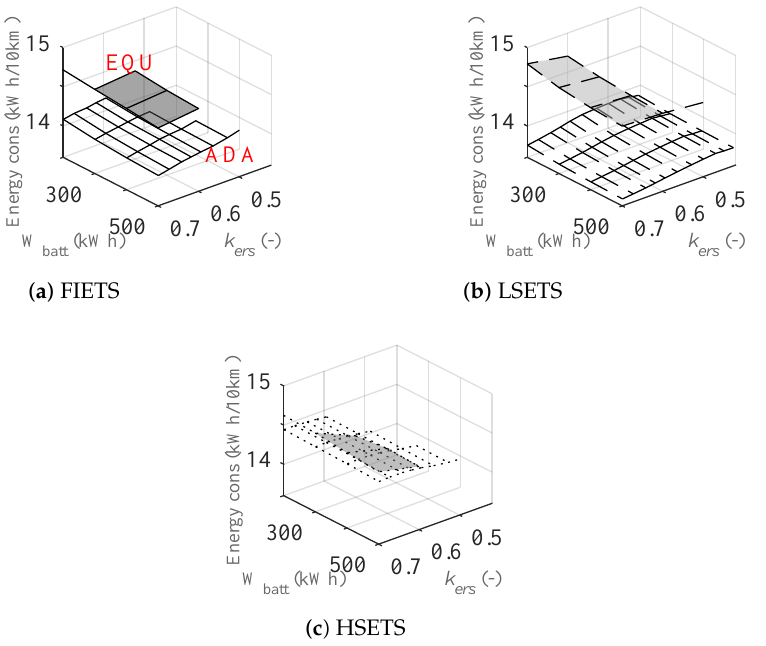
Figure 12. Energy consumption (kWh/10 km) of a long haul truck on a typical long haul drive cycle, as a function of the battery capacity, W batt , and ERS coverage, k ers , with d ers = 10 km. The filled surface corresponds to the EQU ERS placing method whilst the non-filled corresponds to the ADA ERS placing method.